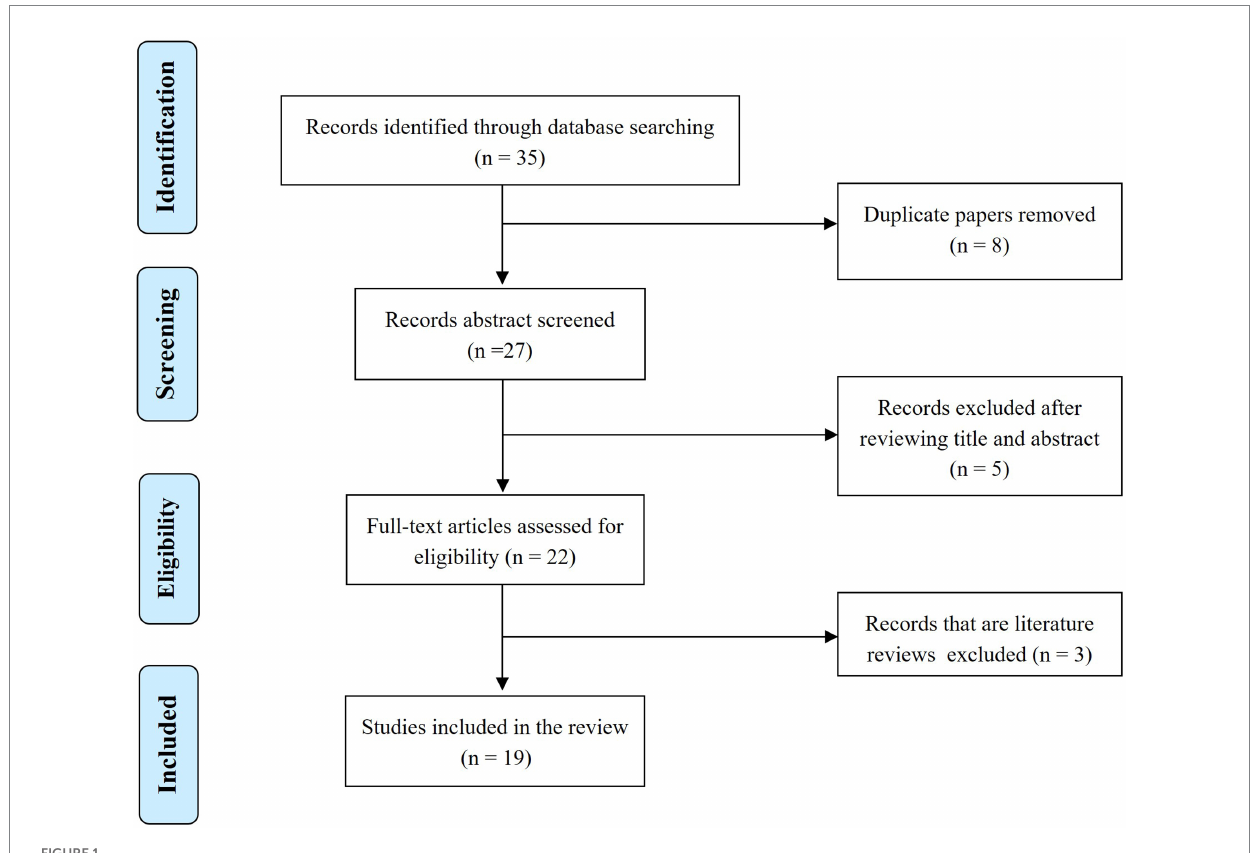
FIGURE 1 Flowchart of study selection